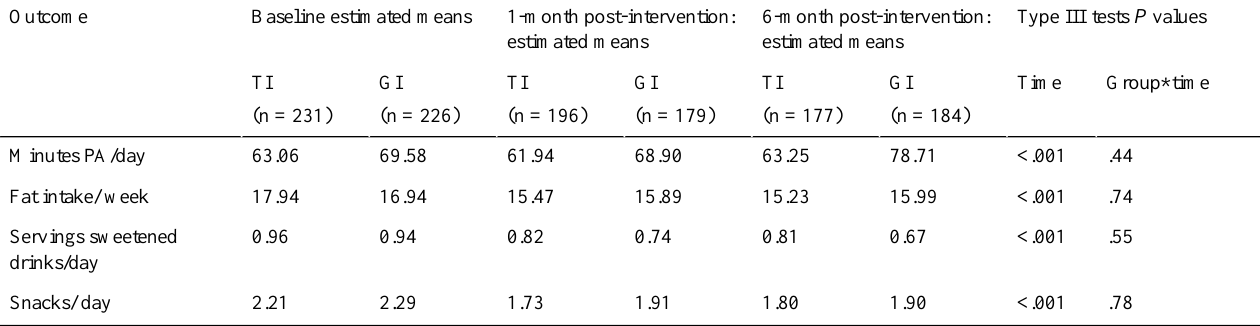
Table 5. Results of general linear mixed model analyses for specific self-reported behavior (DI and PA) at baseline, and 1- and 6-month post-intervention: Estimated marginal means and P values of time and group*time effects